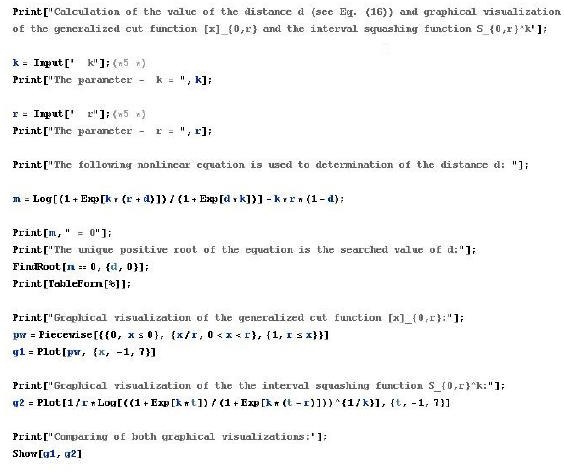
Fig. 7. Module in programming environment MATHEMATICA .